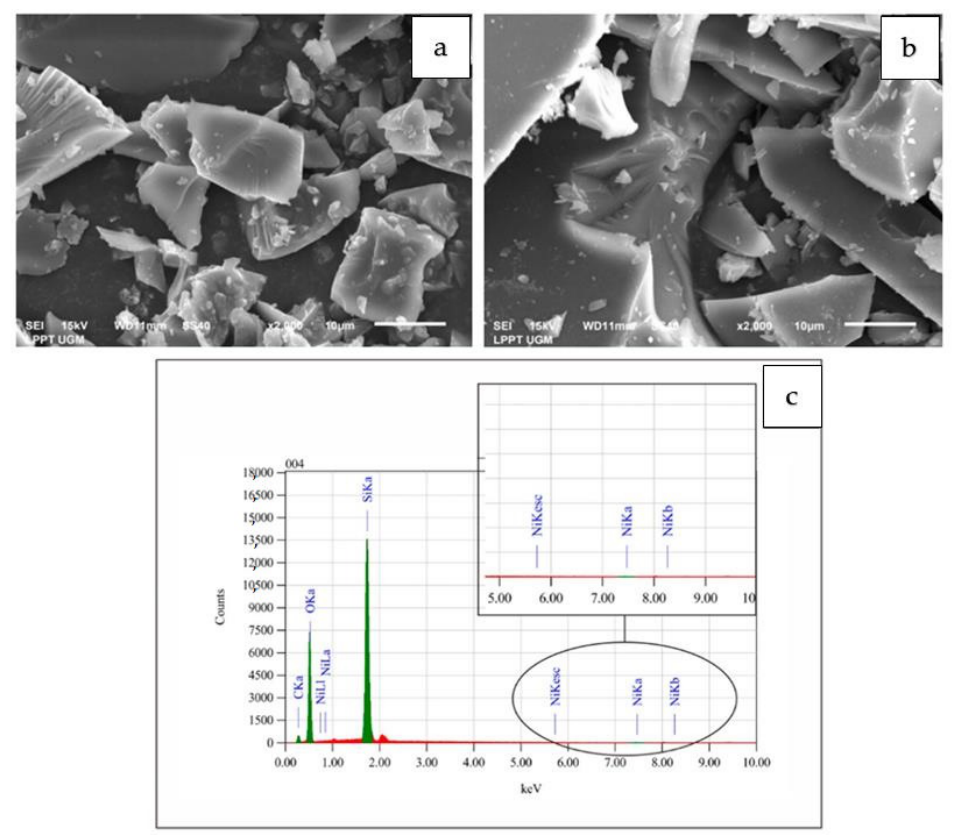
Figure 3. SEM-EDS images of sensor film ( A ) before, ( B ) after Ni 2+ detection and ( C ) sensor’s EDS data of Ni 2+ detection.